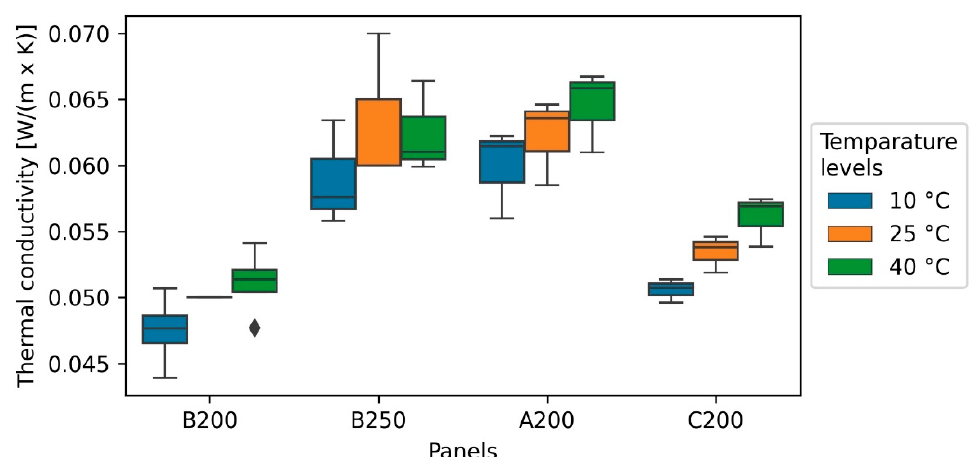
Figure 7. Thermal conductivity of bark fibreboards under different temperature levels (10, 25, and 40 °C).